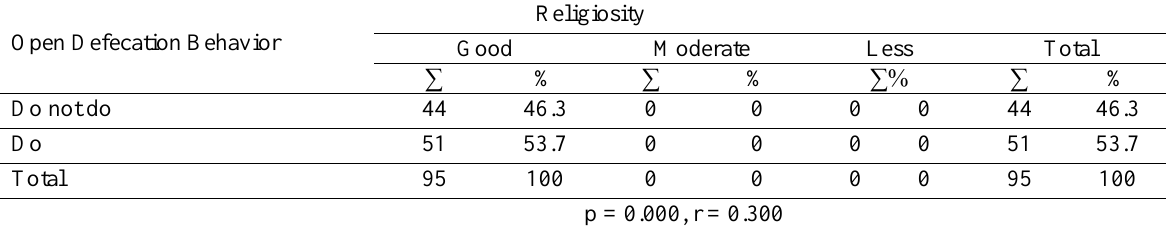
Table 5. Distribution of respondents by cultural value and lifestyle of parents associated with open defecation behavior in school age children Open Defecation Behavior